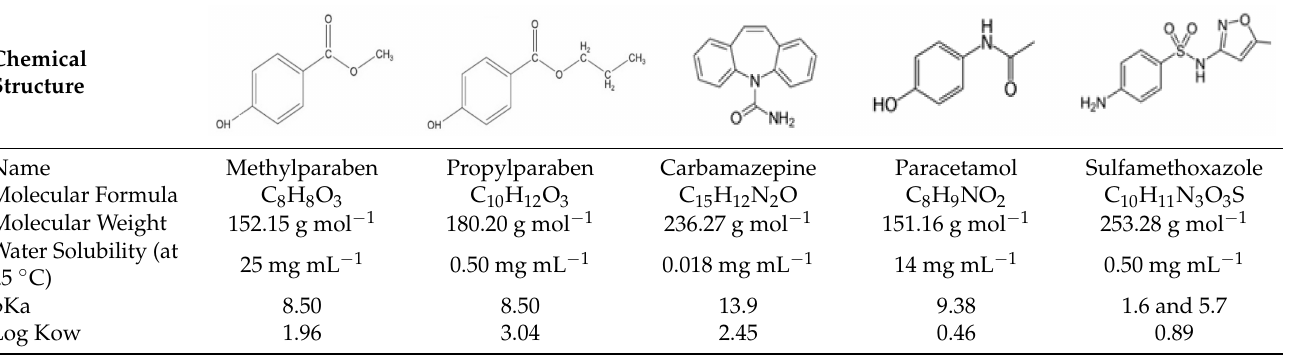
Table 1. Elemental characteristics of PPCPs used in this work.